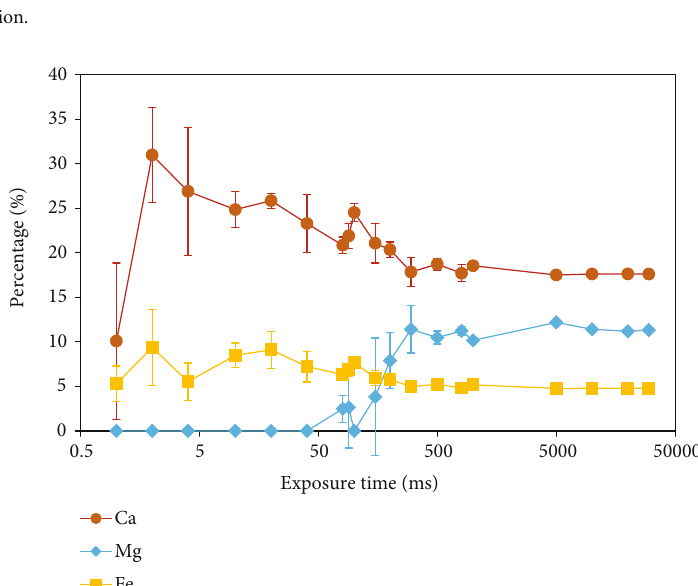
Figure 7: Variations of relative atomic percentages of Ca, Mg, and Fe along with logarithm exposure time at point 2 in Figure